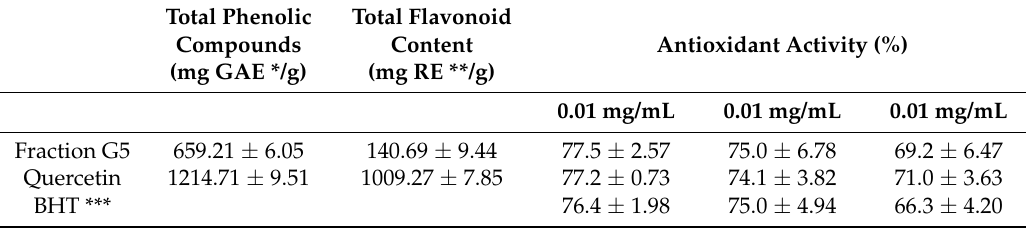
Table 1. Total phenolic compounds, total flavonoid content, and antioxidant activity of G5 fraction from Schinus terebinthifolius Raddi fruit